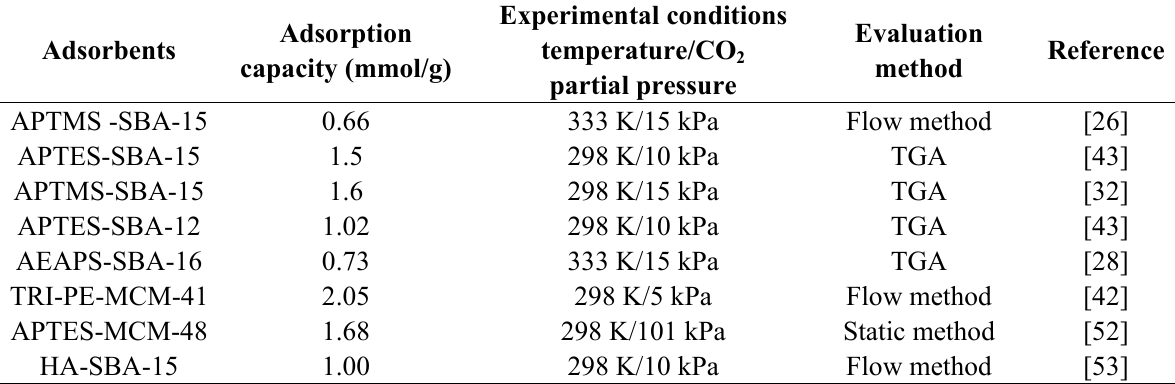
Table 3. The adsorption data of amine-grafted